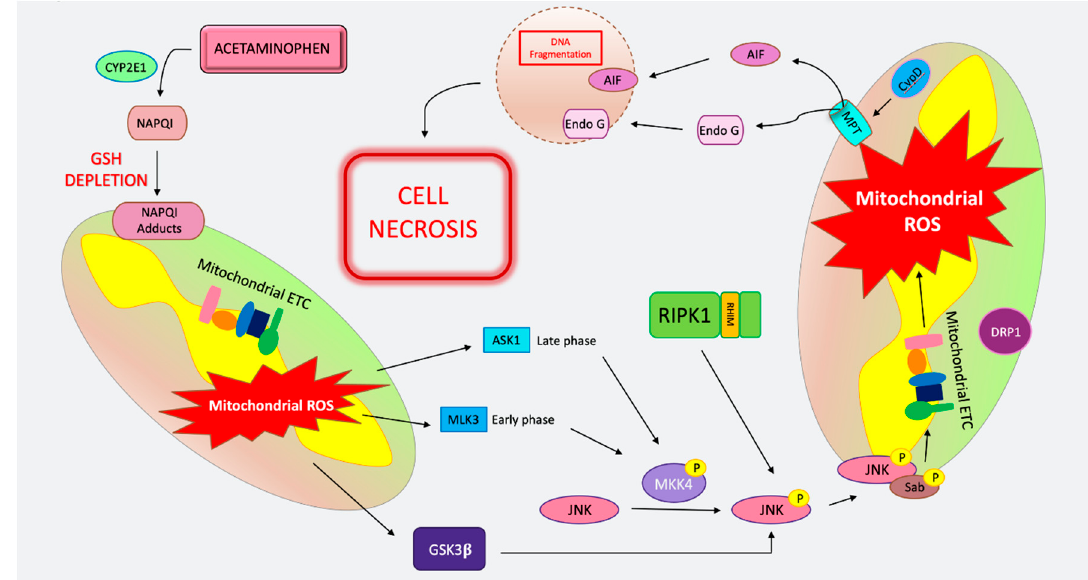
Figure 2. Mechanism of acetaminophen-induced cell death. During conditions of acetaminophen (APAP) overdose, when sulfation and glucuronidation are saturated, excessive APAP is converted by the CYP450 enzymes (mainly CYP2E1) to its reactive metabolite N-acetyl-p-benzoquinone imine (NAPQI). NAPQI is inactivated by conjugating with GSH. However, excessive amounts of